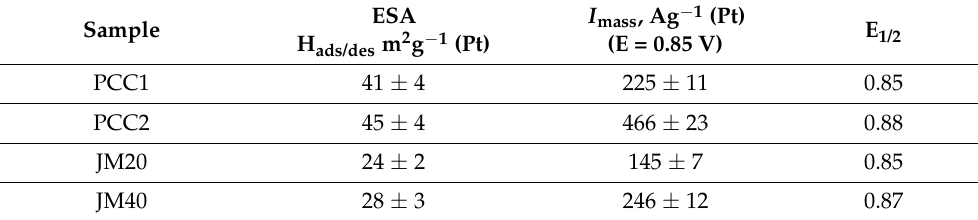
Figure 9. LSV curves for ORR before testing; 1 and 2—after stability tests (2000 cycles): ( a )—commercial sample Pt/C (JM20); ( b )—commercial sample Pt/C (JM40); ( c )—sample PCC1; ( d )—sample PC-2. Potential sweep speed—20 mVs − 1, rotation speed—1600 rpm, 0.1 M HClO4, O2 atmosphere; ( e )—histogram of ESA changes before test; 1 and 2—after test. Table 4. Characteristics of catalysts on completion of voltammetric stress testing of 2000 cycles in the potential range of 0.6–1.4 V.